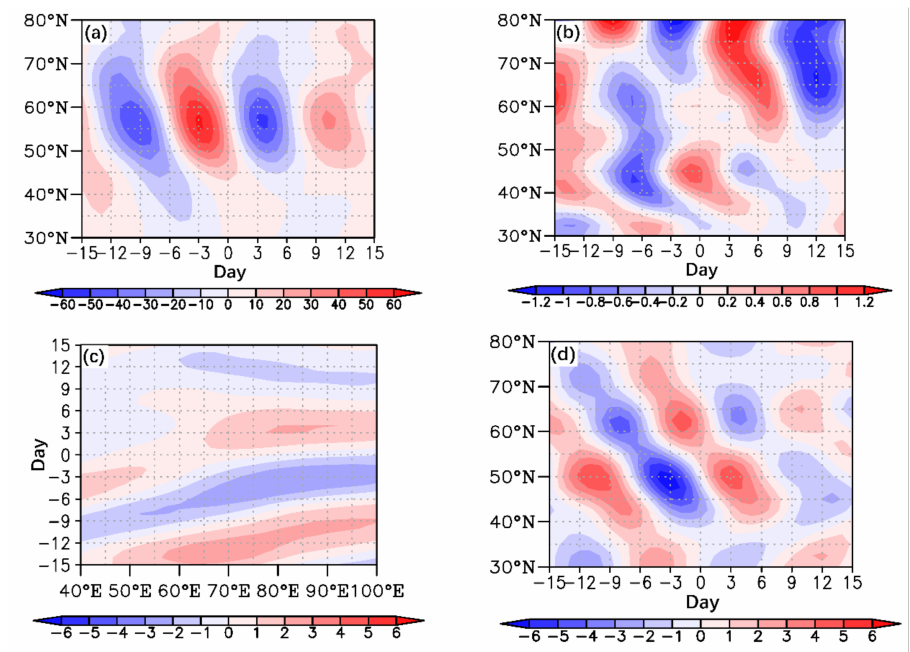
Figure 11. ( a ) The time-latitude section (80 ◦ –90 ◦ E) of the filtered 500 hPa geopotential height; ( b ) the time-latitude section (80 ◦ –90 ◦ E) of the filtered 850 hPa meridional wind; ( c ) the time-longitude section (40 ◦ –60 ◦ N) of the filtered 300 hPa zonal wind; ( d ) the time-latitude section (80 ◦ –90 ◦ E) of the filtered 300 hPa zonal wind 15 days before and after the